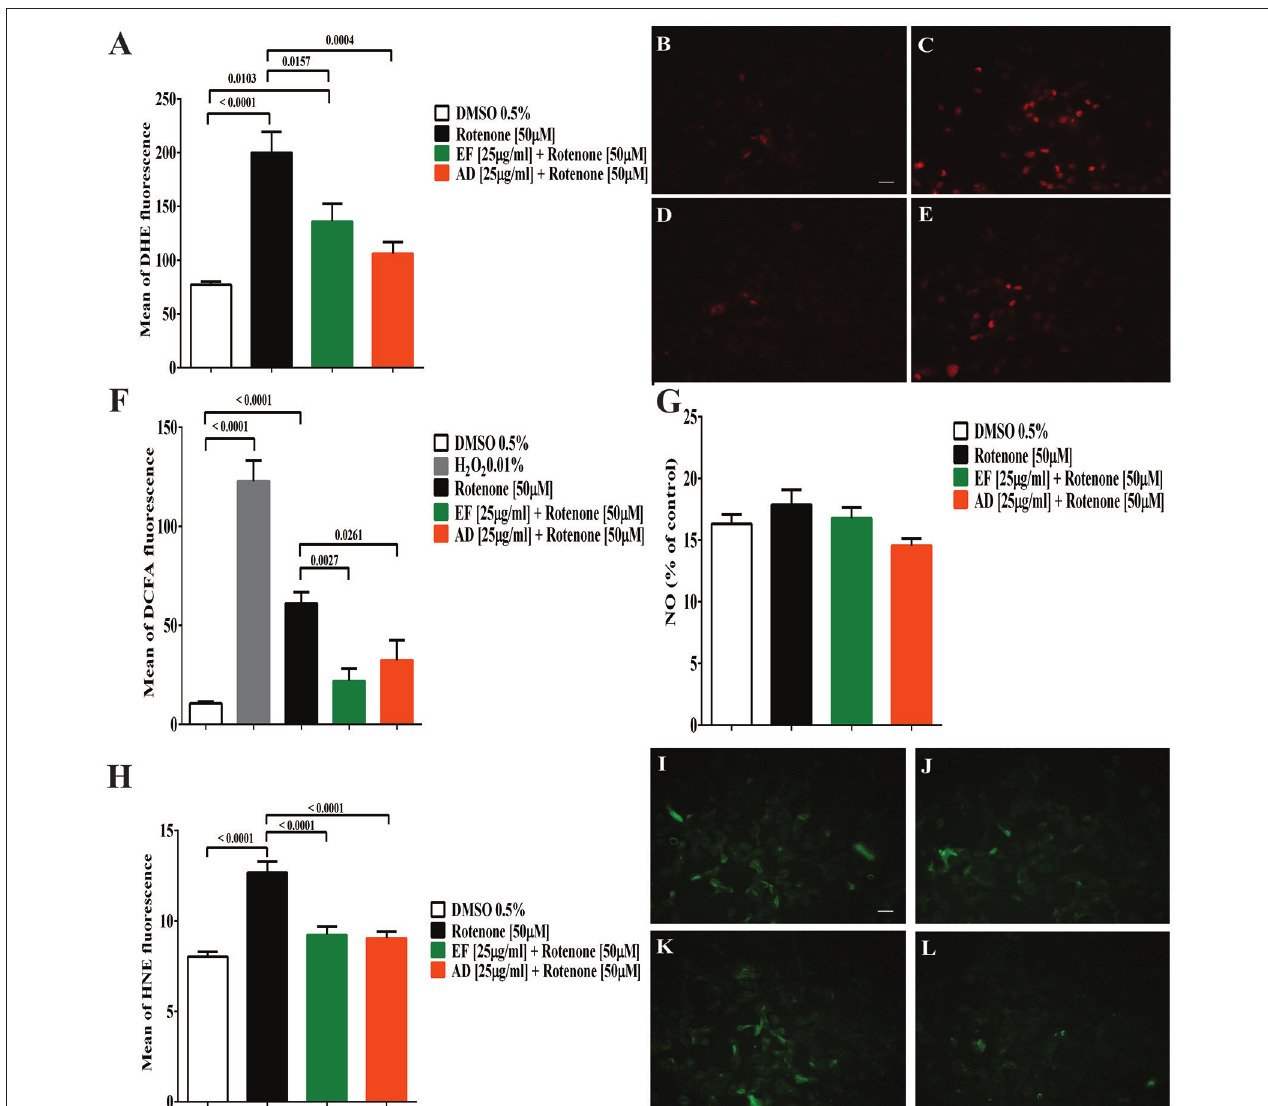
FIGURE 2 | Production of reactive oxygen and nitrogen species (ROS) lipid peroxidation in T98G cells. (A) Mean fluorescence of DHE from superoxide radical in T98G cells. Quantification of superoxide radical in T98G cells after co-treatment with 50 µ M rotenone plus EF or AD at 25 µ g/ml by flow cytometry. Determination of DHE by fluorescence microscopy. (B) Cells exposed to 0.5% DMSO; (C) Cells exposed to 50 µ M rotenone ( p < 0.0001); (D) Cells exposed to 50 µ M rotenone plus 25 µ g/ml EF ( p = 0.0027); (E) Cells exposed to 50 µ M rotenone plus 25 µ g/ml AD ( p = 0.0261). (F) Mean fluorescence of DCFA in T98G cells. Quantification by flow cytometry of hydrogen peroxide in T98G cell cultures after co-treatment with 50 µ M rotenone plus EF and AD (25 µ g/ml). (G) Nitrite concentration in T98G cells determined by Griess reagent after treatment with 50 µ M rotenone and co-treatment with EF and AD at 25 µ g/ml. (H) Mean fluorescence of HNE in cell cultures of T98G after co-treatment with rotenone 50 µ M plus EF and AD at 25 µ g/ml. Determination of HNE by fluorescence microscopy. (I) Cells exposed to 0.5% DMSO; (J) Cells treated with 50 µ M rotenone ( p < 0.0001); (K) Cells co-treated with 50 µ M rotenone plus EF (25 µ g/ml; p < 0.0001); (L) cells co-treated with 50 µ M rotenone and 25 µ g/ml AD ( p < 0.0001). Bar scales: 10 µ